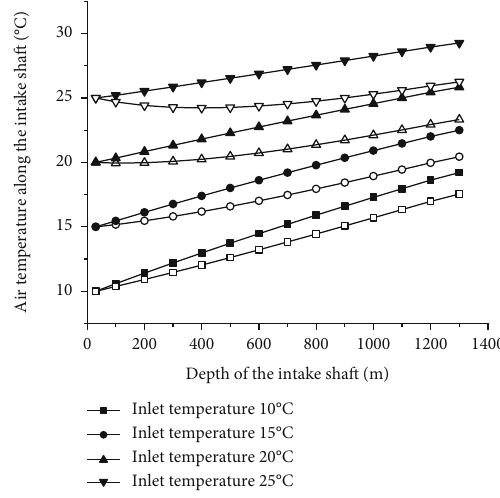
Figure 6: E ff ect of temperature and humidity of inlet air on the air temperature along the shaft.